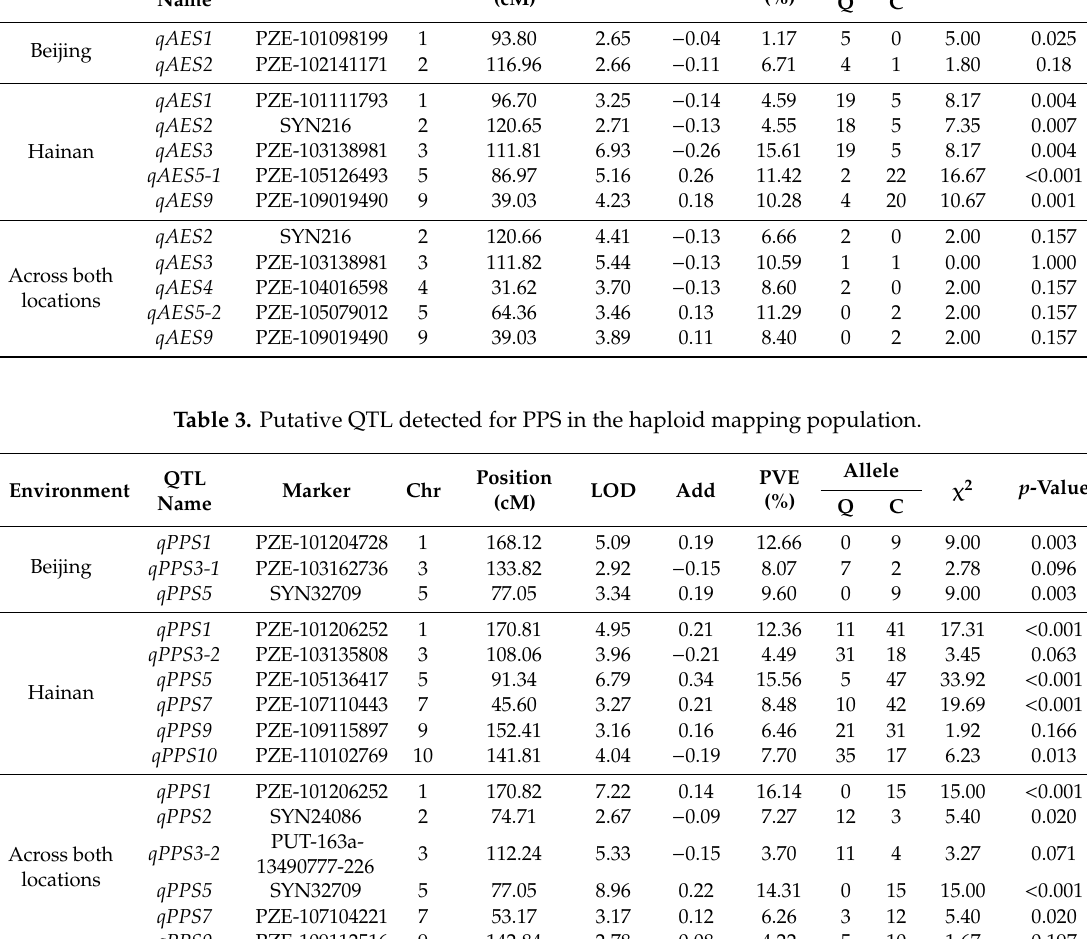
Table 2. Putative QTL detected for AES in the haploid mapping population. Environment